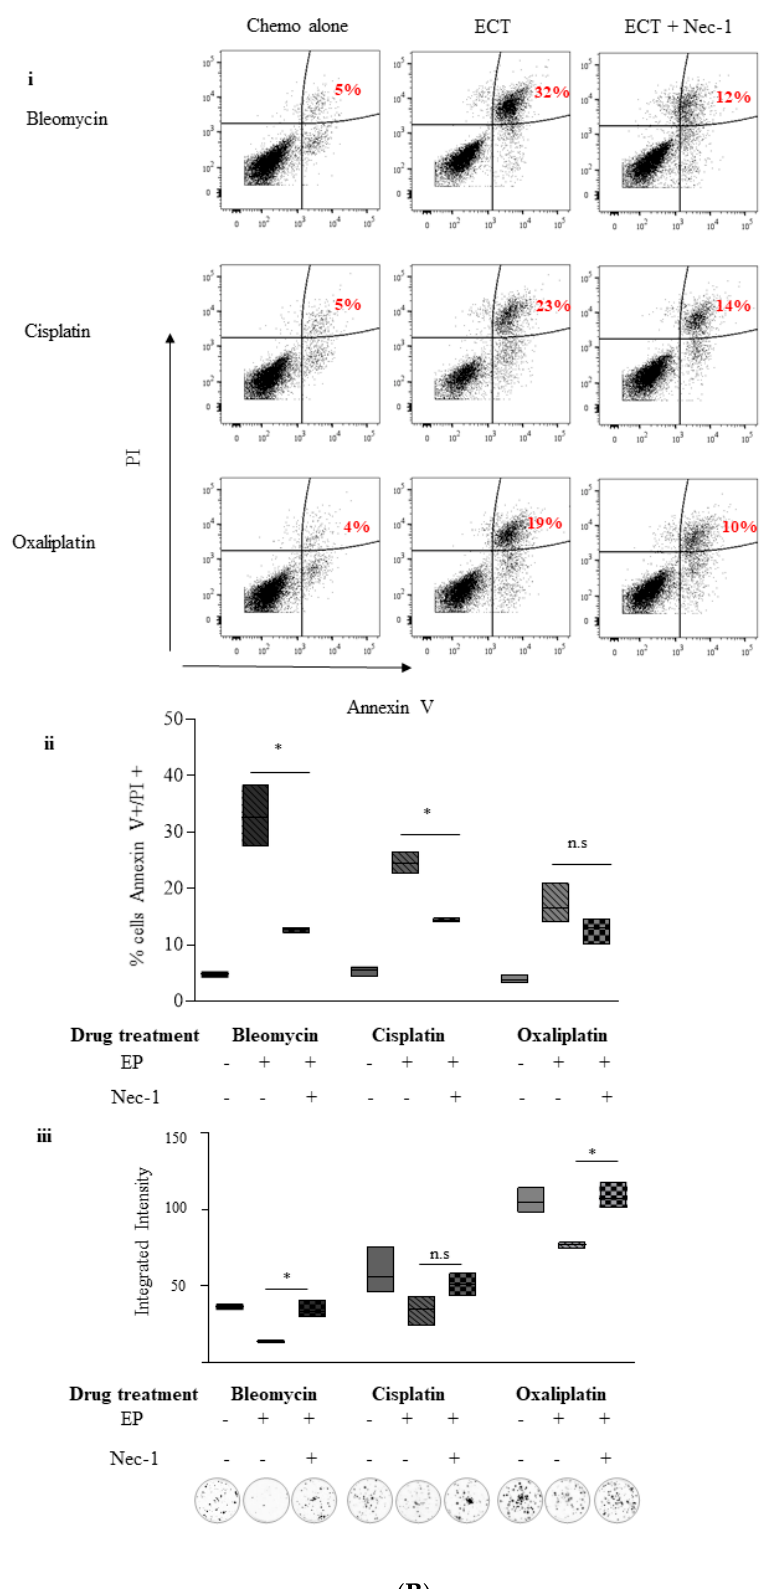
Figure 5. Necrostatin-1 is su ffi cient to reduce the Annexin V positive, PI positive PANC-1 population following ECT and improves recovery following Bleomycin ECT treatment. (PANC-1 cells ( A ) or